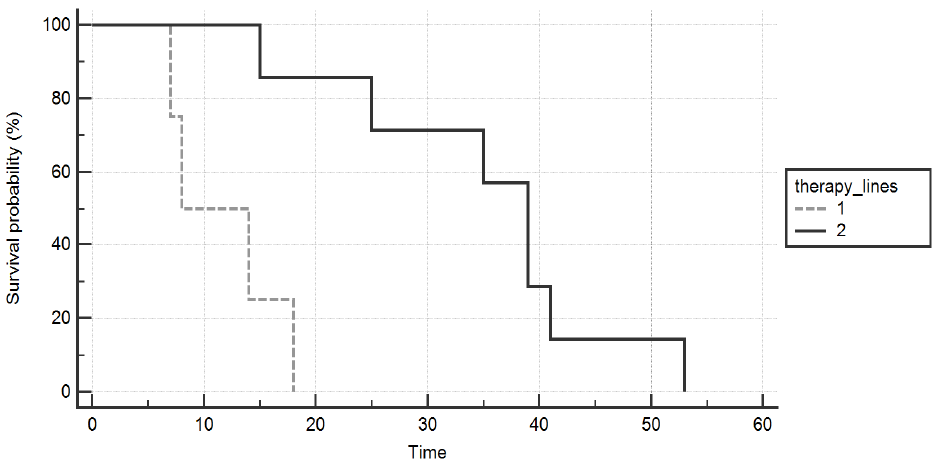
Figure 2. Kaplan–Meier curves comparing the overall survival (months) of patients who were treated